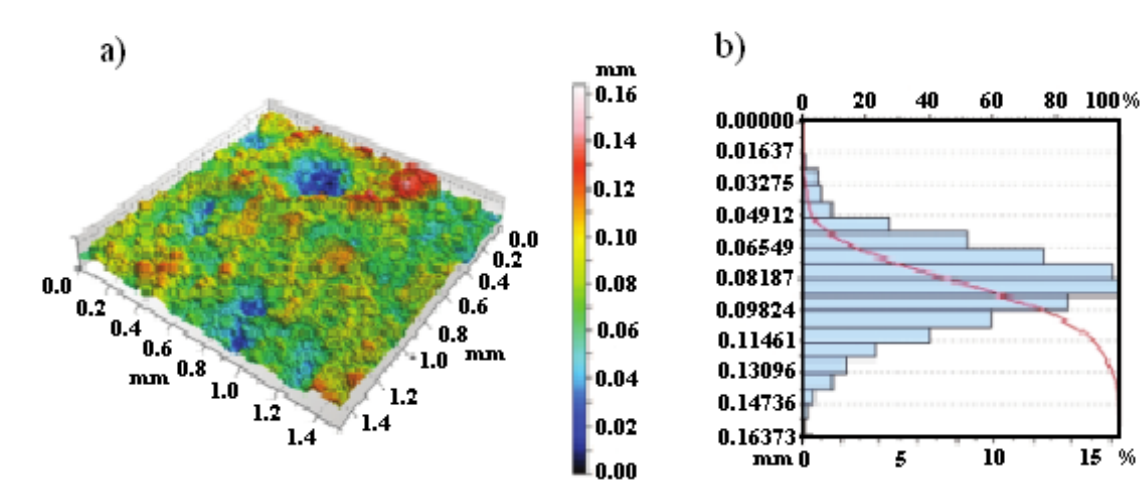
Figure 8. Structure of the Cr 3 C 2 -25(Ni20Cr) cermet coating on the Al7075 substrate after laser remelting for the spot speed of 600 mm/min: ( a ) coating topography, ( b ) depth histogram.